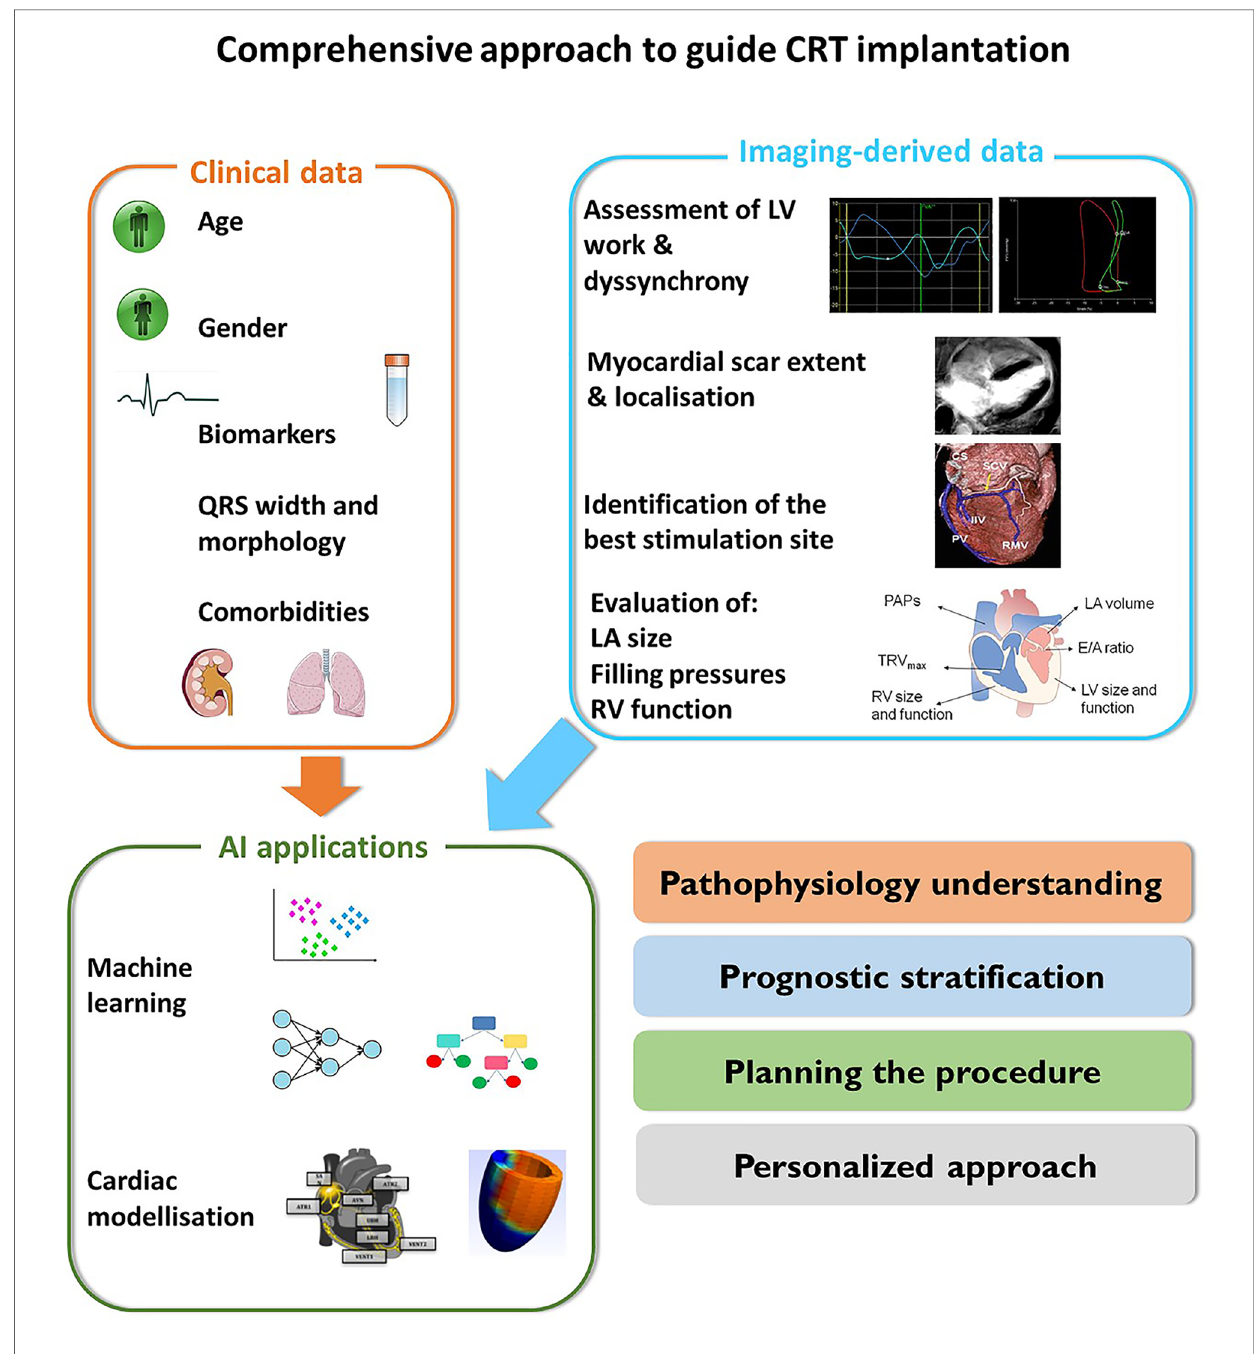
FIGURE 5 A comprehensive approach to guide CRT